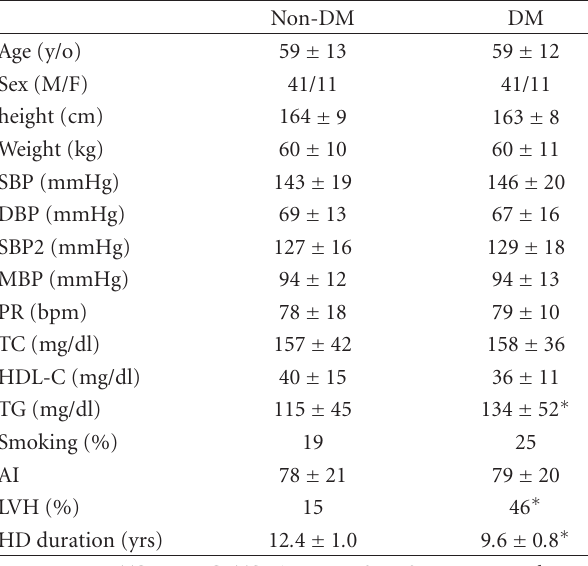
Table 1: Demographic feature of participating patients.